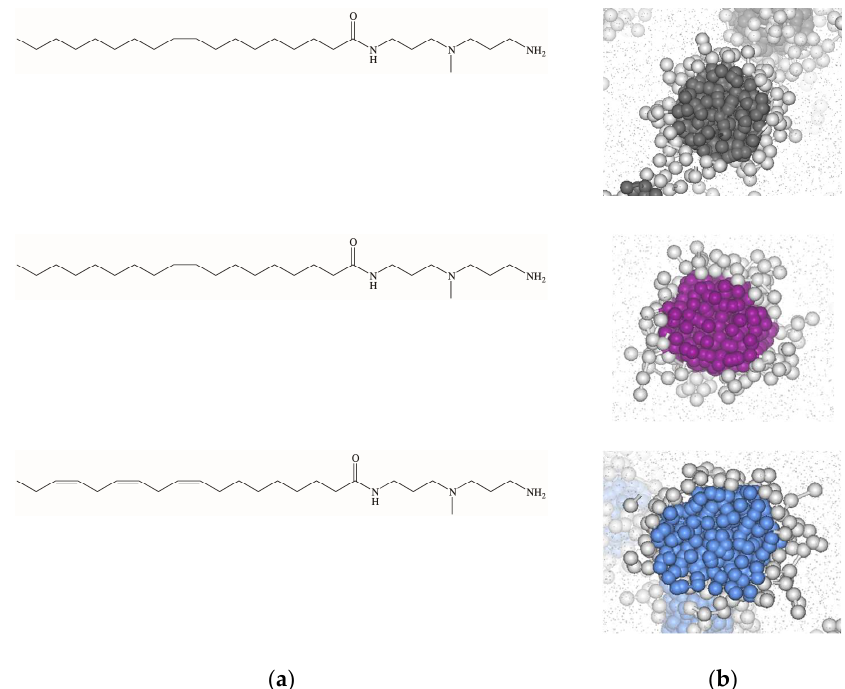
Figure 12. ( a ) Structures of the amphiphilic C 18 G 0 dendrons bearing 1 ( C 18,1 G 0 , top), 2 ( C 18,2 G 0 , middle), and 3 ( C 18,3 G 0 , bottom) cis -alkene groups, respectively. ( b ) Mesoscale structures of the spherical micelles of the self-assembled dendrimer C 18,1 G 0 (top, left), C 18,2 G 0 (top, right), and C 18,3 G 0 (bottom). The hydrophobic micellar core is shown in color while the hydrophilic DAPMA portion is portrayed in light gray. Solvent and ions are represented by a dotted field. Adapted from [25] with the permission of John Wiley & Sons. Table 4. Computational and experimental characterization of the self-assembled dendrimers formed by the three dendrons featuring different degrees of unsaturation in their hydrophobic part in 150 mM NaCl buffered solution (10 mM Tris-HCl, pH = 7.4). Adapted from [25], with the permission of John Wiley & Sons.